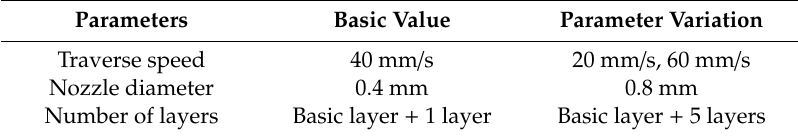
Figure 4. The models designed for 3D rubber printing based on the usual test prints [28]: ( a ) Sample 1 with geometric shapes as the inner contour and ( b ) Sample 2 with geometric shapes as the outer contour (the minimum dimensions are limited by the nozzle diameter of 0.4 mm). Table 2. The basic values and parameter variations for the printing